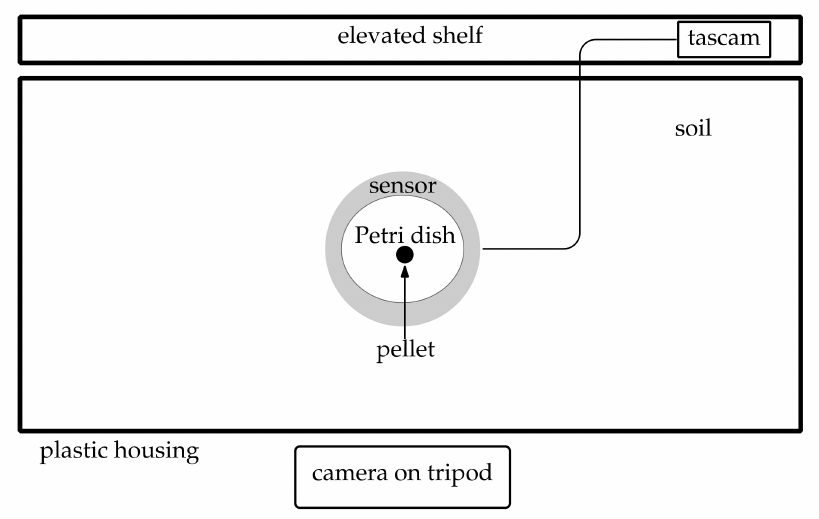
Figure 2. Audio and video equipment setup used to record bioacoustics in arena experiments, not to